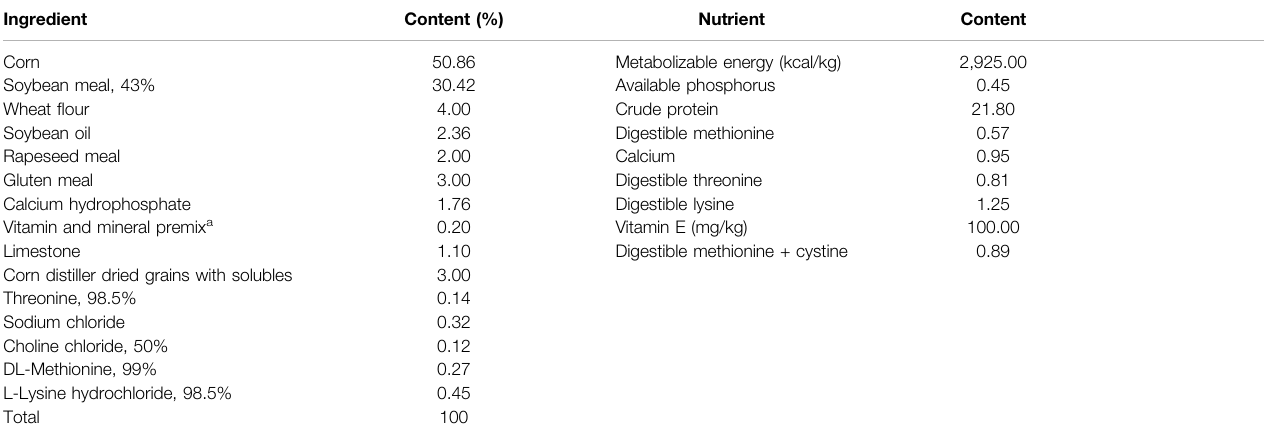
TABLE 1 | Ingredient composition and calculated nutrient content of the basal diet (Offspring ’ s diet) (%, as fed-basis).